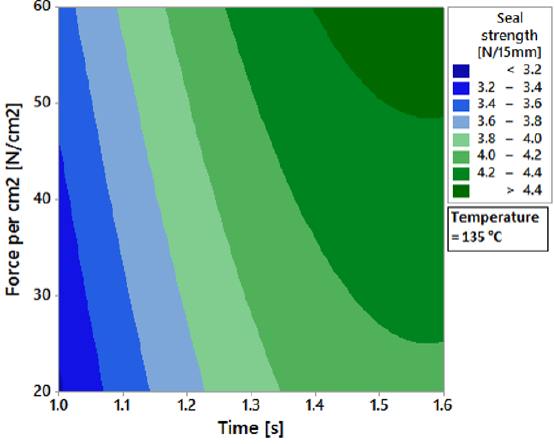
Figure 10 – Contour plot of Seal strength vs. Force per cm 2 and